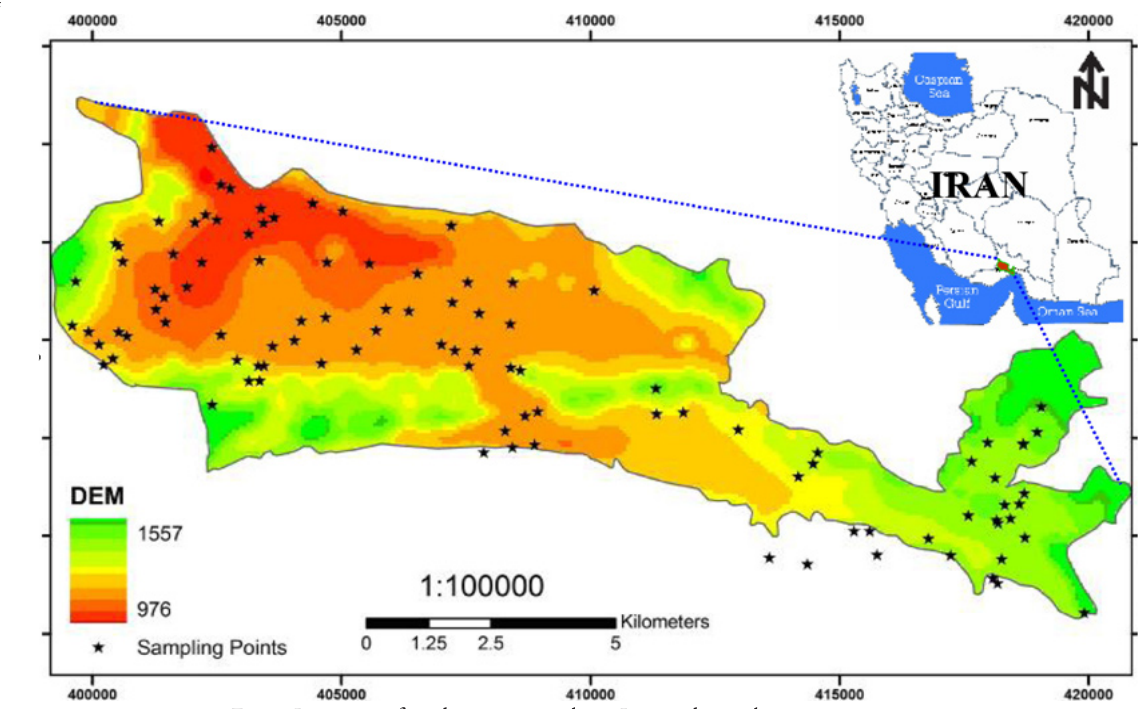
Fig. 1. Location of study area in southern Iran and sampling points